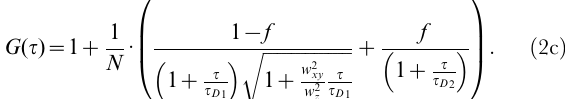
are the lateral diffusion times for the unbound and bound ligand, respectively. The relative amount of unbound versus bound ligand molecules is given by the ratio of (1 2 f ) over f .